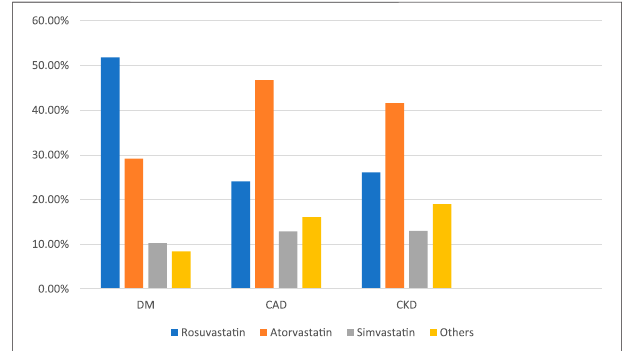
FIGURE 3 | Preferred statin in COVID-19 patients.